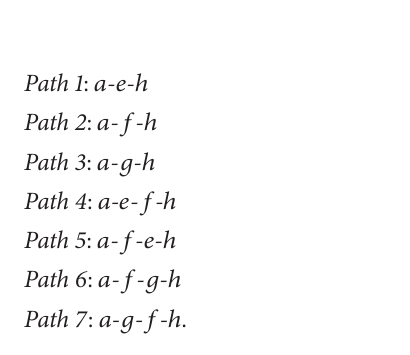
Figure 7: SE 𝑚 of size 2 × 4